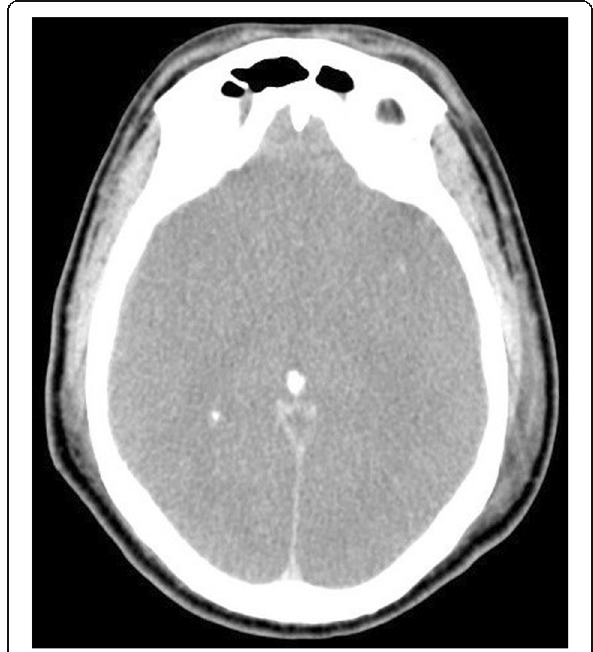
Fig. 5 Brain Scan, 03/16/2020, swelling of whole brain